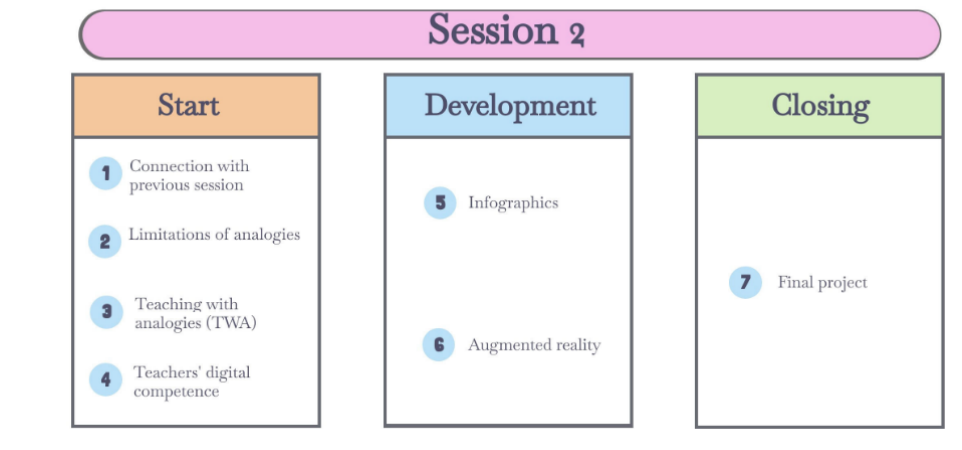
Figure 5. Structure – session